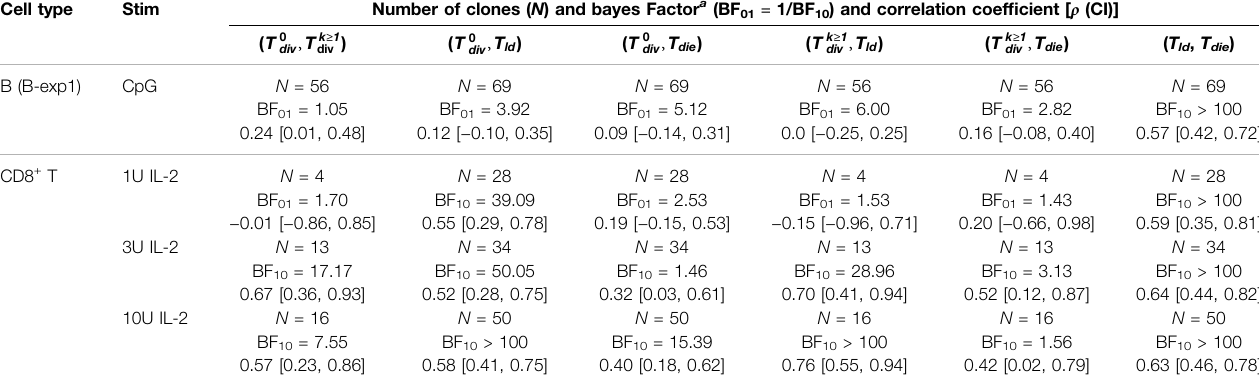
TABLE 1 | Bayesian independence test of the times to fates extracted from B and CD8 + T cell fi lming datasets. For each pair of the times to fates, the correlation coef fi cient was estimated with 95% credible interval using bivariate normal distribution and Bayes Factor (BF) was calculated. Given two hypotheses (H 0 : ρ (cid:2) 0 and H 1 : ρ ≠ 0), if the data is more probable under H 0 , then it is BF 01 times more favoured than H 1 , otherwise H 1 is BF 10 times more favoured than H 0 . Cell type